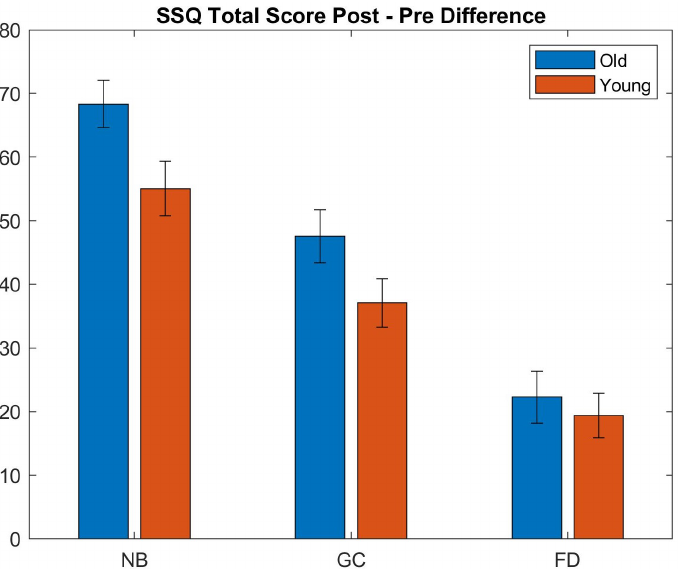
Figure 17. Comparison of the Post–Pre difference of the SSQ scores for each condition with respect to age groups (conditions: NB—No Blur; GC—Unity Blur; FD—Ours). The plot shows the changes in individual SSQ total scores between the Pre and Post experiment conditions for the two age groups.